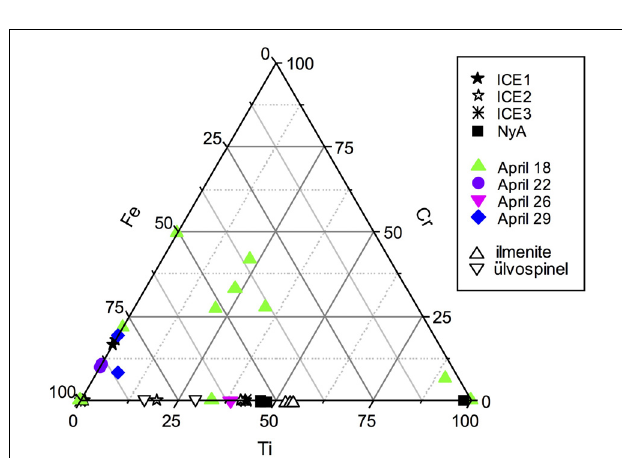
FIGURE 11 | Ternary diagram Ti-Cr-Fe of the chemical composition of the metal oxide particles in the aerosol samples. Data from SEM-EDS microanalysis. The composition of NyA and ICE sediments and of reference mineral are also reported for comparison. The composition of rutile fits the right corner of the triangle.